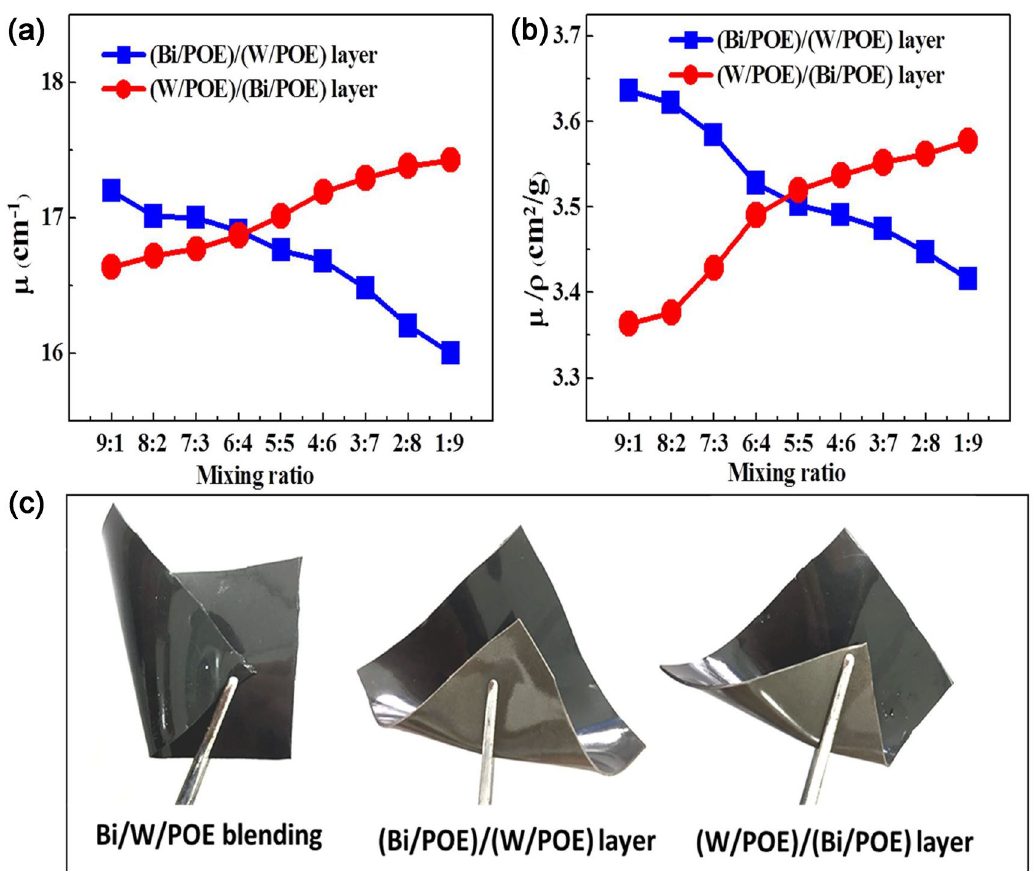
Figure 3. ( a ) Linear attenuation coefficient versus the layer thickness ratio; ( b ) Mass attenuation coefficient versus the layer thickness ratio; ( c ) Digital images of the flexible